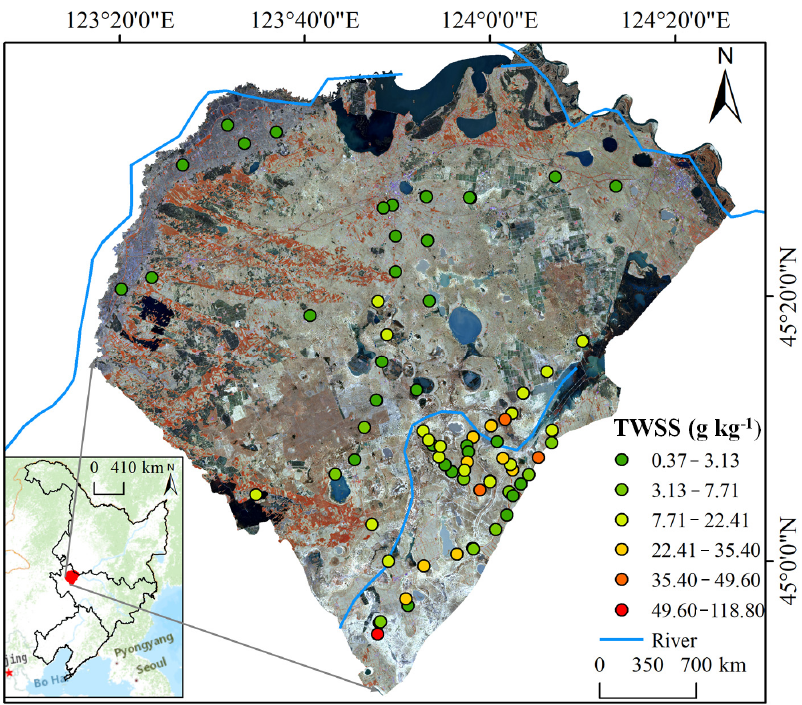
Figure 1. Distribution map of soil samples in the study area. TWSS is the total water-soluble salt.